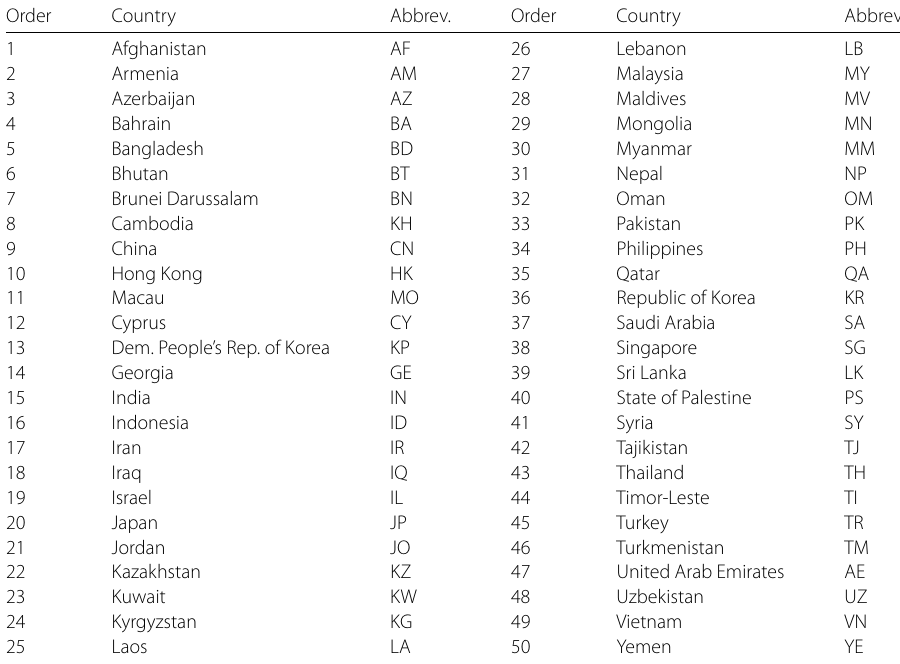
Table 1 Ordered list of Asian countries with abbreviation codes Order Country Abbrev. Order Country